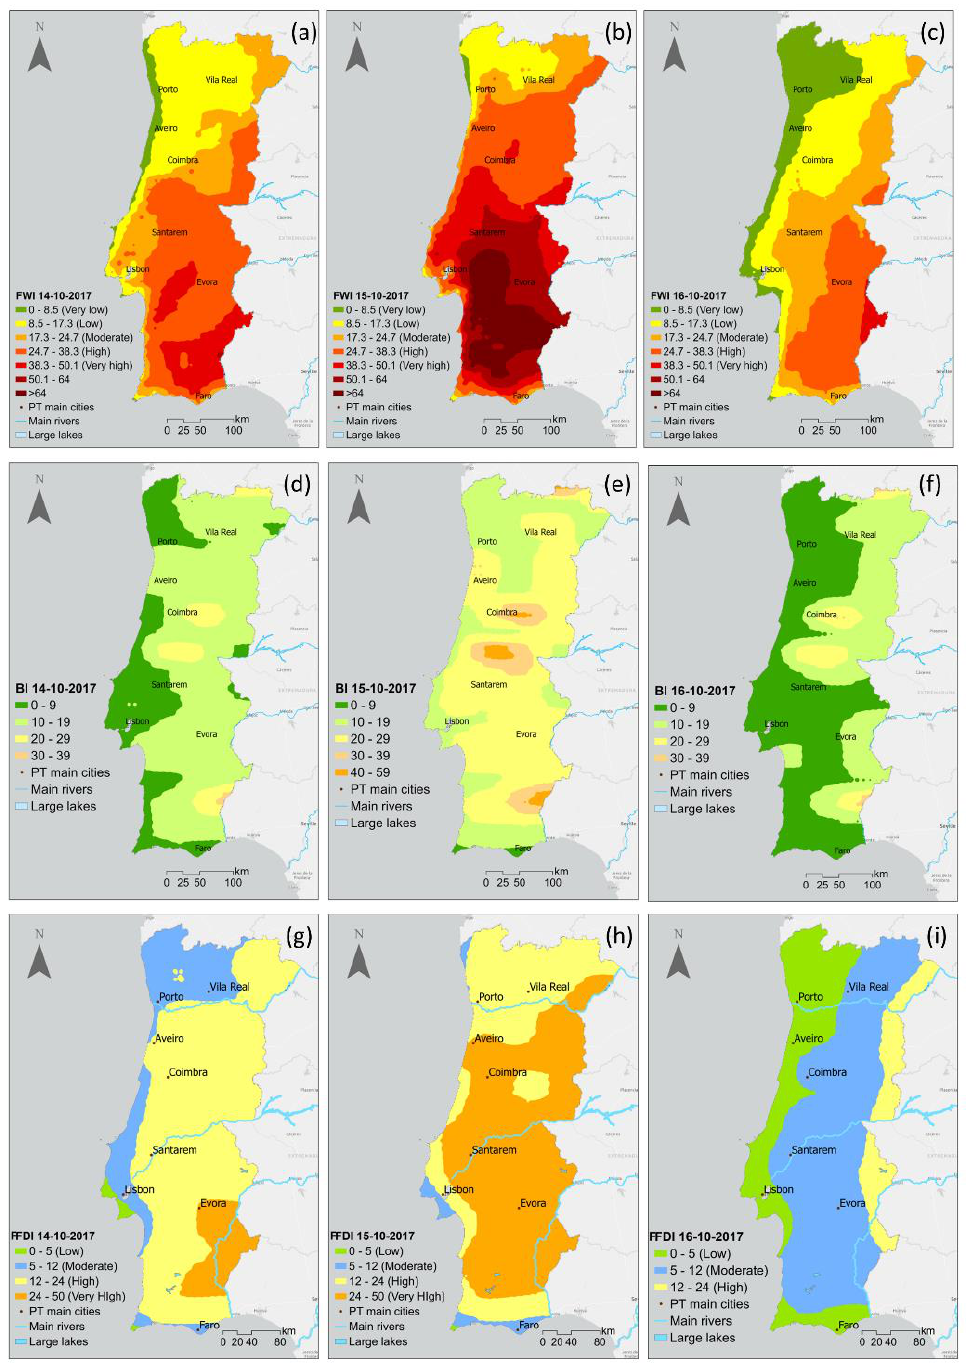
Figure 5. Daily mean values for ( a , d,g ) 14, ( b,e,h ) 15, and ( c,f , i ) 16 October 2017, for FWI (upper row), BI (middle row), and FFDI (lower row).